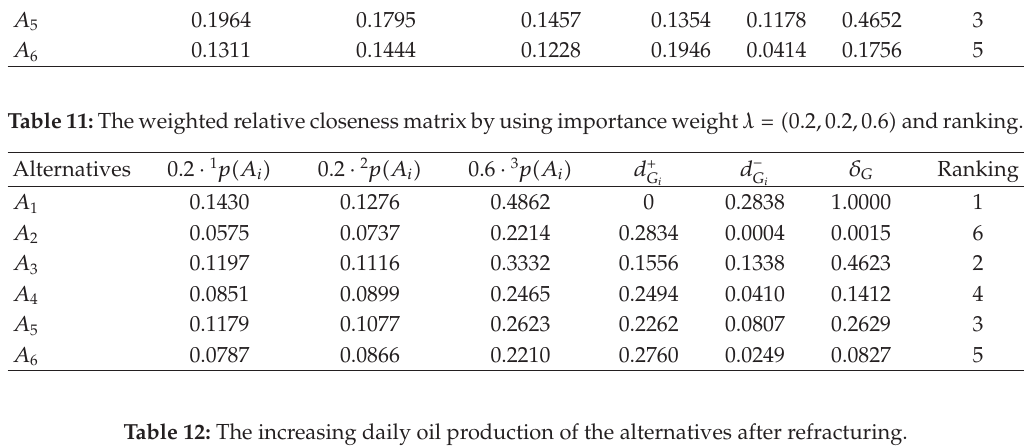
Table 12: The increasing daily oil production of the alternatives after refracturing.